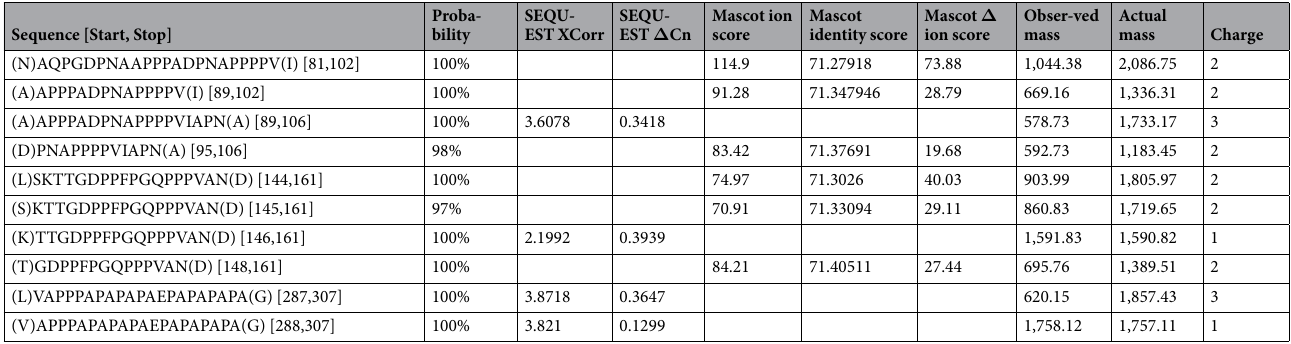
Table 4. Peptides identified from RP-HPLC analysis of fraction 8 of pronase digested native